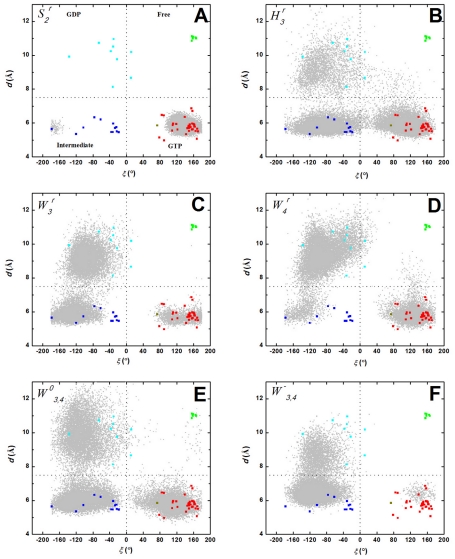
Re-distribution of conformational states by structural waters.
d/ξ values from MD (gray) are overlaid with those from x-ray structures (symbols) for simulations  (A);  (B);  (C);  (D);  (E); and  (F). See legend of Fig. 4 for color scheme and Table 1 for simulation names.